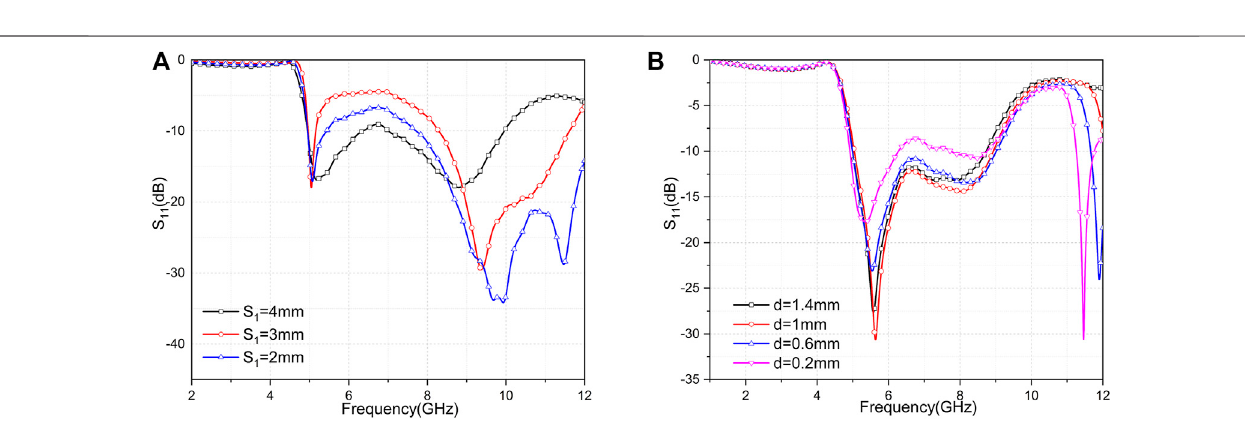
TABLE 2 | Parameter values of the bandpass fi lter with CPW structure based on SRR (unit: mm). Parameter values of bandpass fi lter with CPW structure based on SRR (unit: mm)